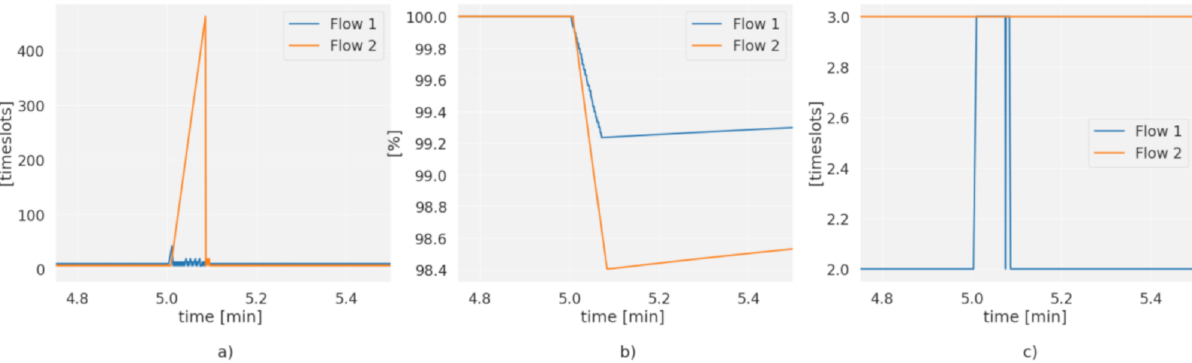
Figure 17. Performance with simulated failure in testbed; ( a ) Packet inter arrival time; ( b ) Packet delivery ratio; ( c ) End to End